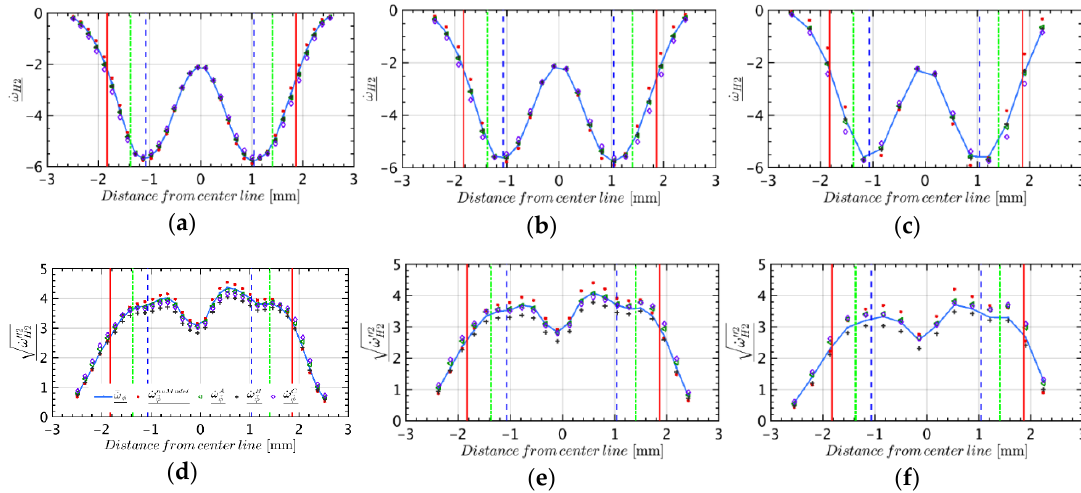
Figure 3. Production/consumption rate of H 2 with units (kg/(m 3 s)), (-) filtered DNS, ( ∗ ) “no model”, ( ◁ ) SS Model A, ( ) SS Model B, ( ◇ ) SS Model C: ( a , b , c ) Mean; and ( d , e , f ) root mean square (RMS). Different filter widths are applied: ( a , d ) ∆/∆ DNS = 8; ( b , e ) ∆/∆ DNS = 12; and ( c , f ) ∆/∆ DNS = 18. The data are extracted at 𝑡 = 20𝑡 𝑗 . vertical dashed-blue lines: planes of maximum mean turbulent kinetic energy (TKE); vertical dot-dashed green lines: planes of mean stoichiometric mixture fraction; and vertical red lines: planes of maximum mean temperature fluctuations.